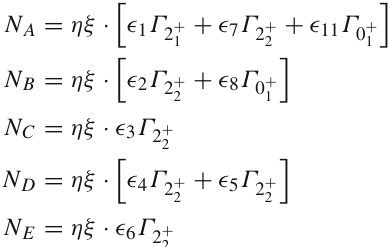
The number of decays N i corresponding to the i th sig- nature can be written as a function of the exposure ξ = 2 . 24 × 10 25 emitters · yr, the detection efficiency (cid:10) i (Table 1), the data selection efficiency η (Sect. 5) and the width of the corresponding decay channel ( Γ